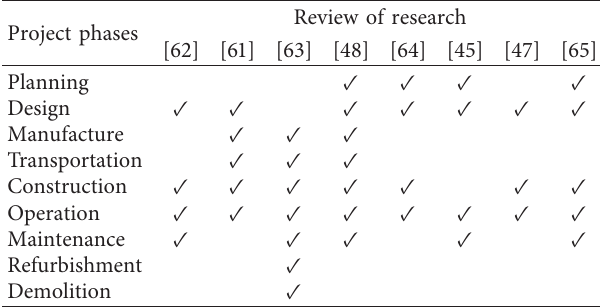
Table 3: Project lifecycle in existing